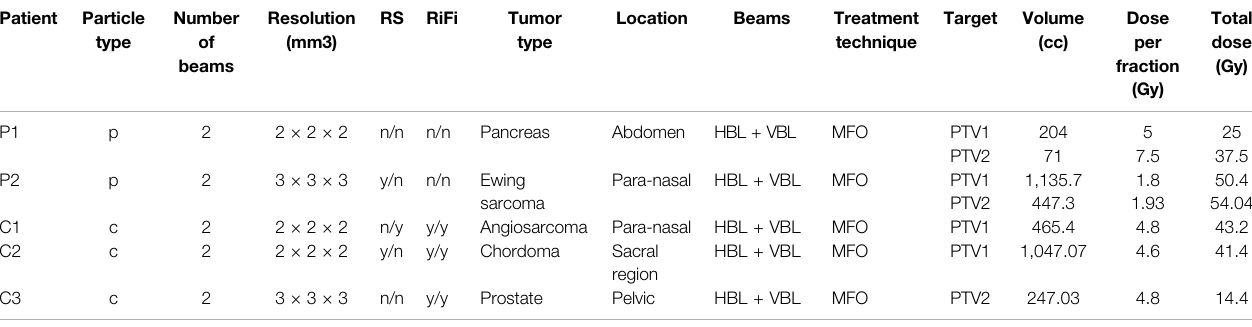
TABLE 1 | Description of the clinical treatment plans veri fi ed with IDEAL. The columns RS and RiFi indicate the presence (y)/absence (n) of range shifter and ripple fi lters for each of the 2 beams used for each treatment. In the column Beams, HBL and VBL indicate usage of Horizontal and Vertical Beam Lines. Patient Particle type